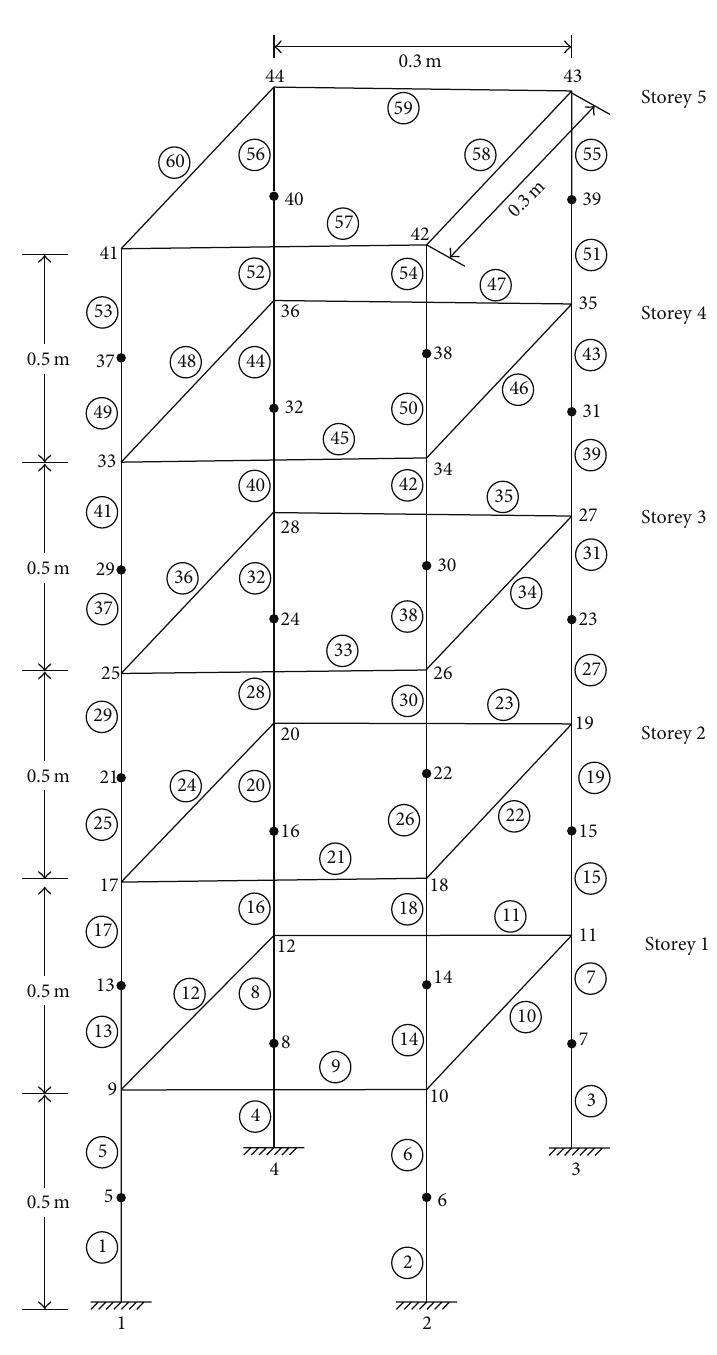
Figure 9: Space frame